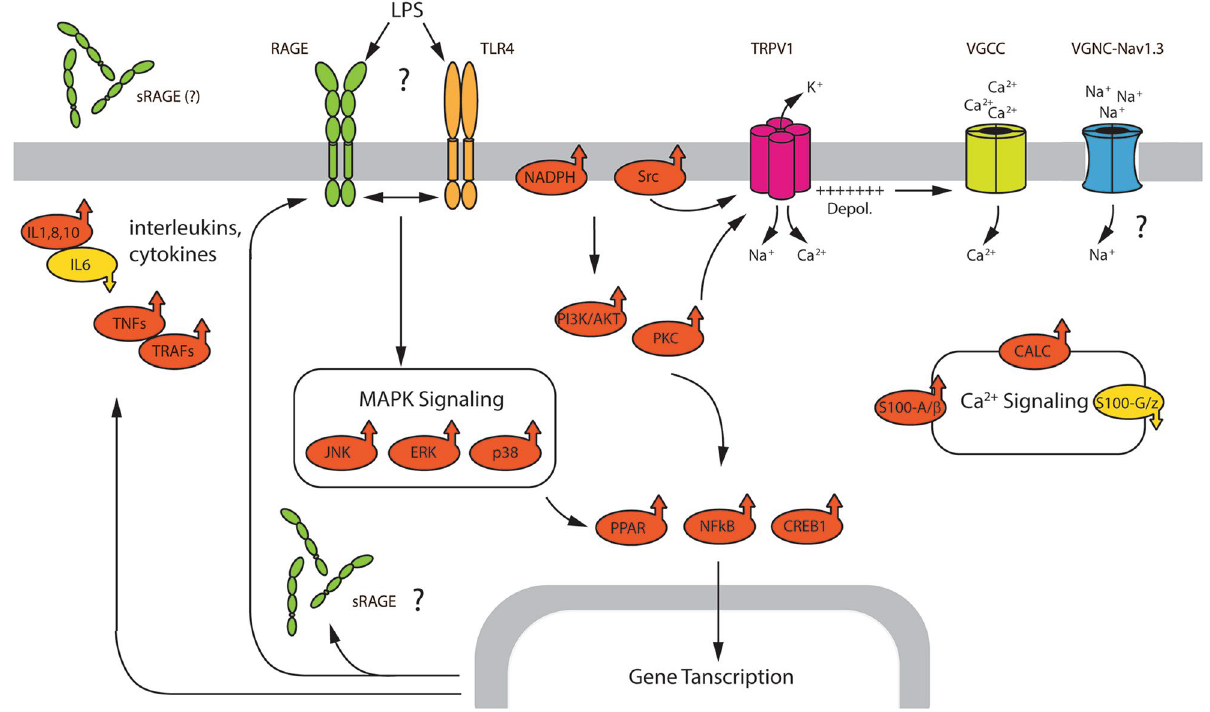
Figure 6. Working model of LPS-induced RAGE signaling in sensory neurons innervating the upper airways. The schematic diagram summarizes the global protein changes in intracellular pathways and membrane receptors detected by in tDRG neurons from WT mice exposed to either PBS (control) or LPS, as revealed by mass spectrometry (MS)-based proteomics. Pathway proteins in red-arrow up indicate protein upregulation, and in yellow-arrow down indicate downregulation. All abbreviations correspond to nomenclature used in Table 2, except for: VGCC, voltage-gated Ca 2+ channels; VGNC-Nav1.3, voltage-gated Na + channel containing the Nav1.3